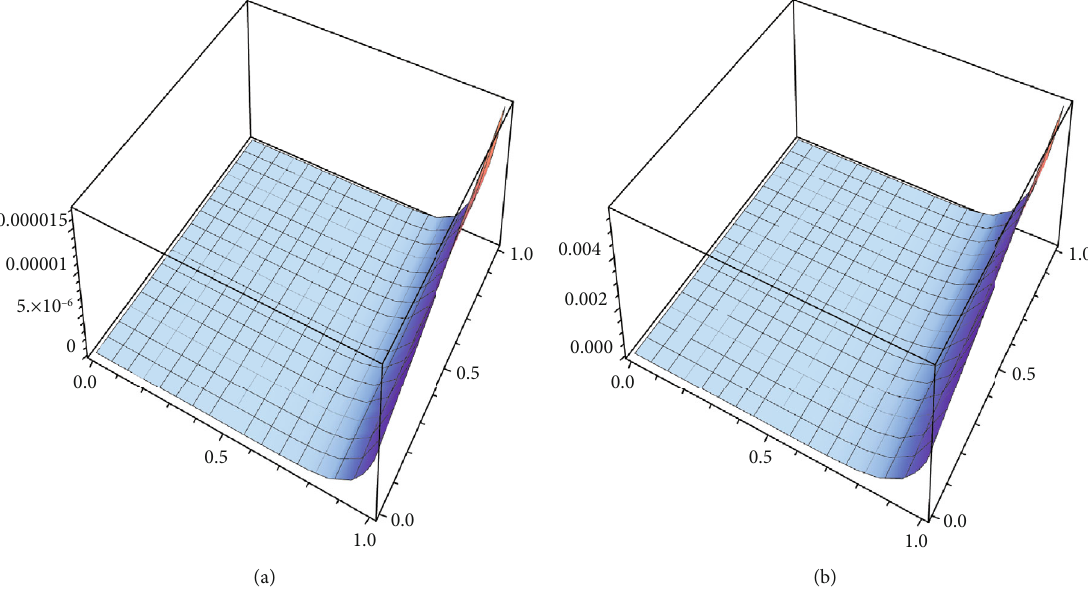
Figure 8: The absolute error between exact solution and tenth-order approximate solution: (a) α = 1 : 4 and (b) α = 1 : 2